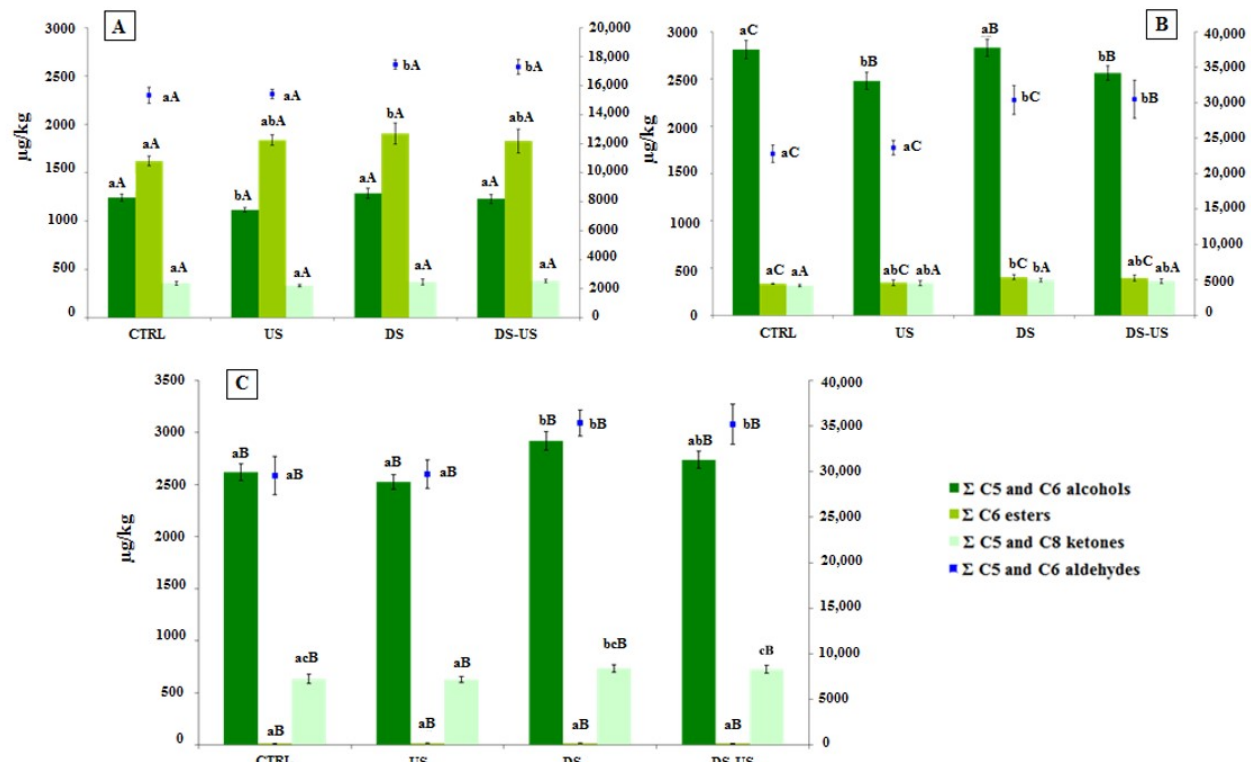
Figure 7. Volatile composition ( µ g/kg) of Peranzana ( A ), Canino ( B ) and Coratina ( C ) EVOOs. Volatile content was expressed as C5 and C6 saturated and unsaturated alcohols (sum of 1-pentanol, 1-penten-3-ol, (E)-2-penten-1-ol, (Z)-2-penten-1-ol, 1-hexanol, (Z)-2-hexen-1-ol, (E)-2-hexen-1-ol, (Z)-3-hexen-1-ol, and (E)-3-hexen-1-ol), primary axis; C6 esters (sum of hexyl acetate and (Z)-3-hexenyl acetate), primary axis; C5 and C8 ketones [3-Pentanone, 1-Penten-3-one and 6-Methyl-5-hepten-2-one], primary axis; C5 and C6 saturated and unsaturated aldehydes (sum of pentanal, (E)-2-pentenal, hexanal, (E)-2-hexenal and (E,E)-2,4-hexadienal), secondary axis. The data are the mean values of the three samples analyzed in triplicate ± standard deviation. For each different cultivar, the values of each volatile group with different lower-case letters are significantly different from one another ( p < 0.05). For each different test, the values of each volatile group of the three cultivars with different upper-case letters are significantly different from one another ( p < 0.05). CTRL = control test, US = ultrasound test, DS = destoned test, DS-US = destoned-ultrasound test.